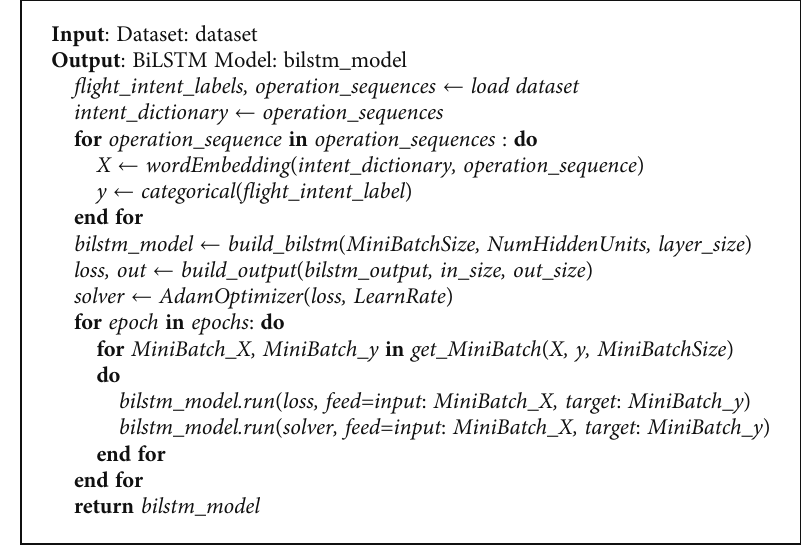
Algorithm 1: The training of the single-pilot intention model based on